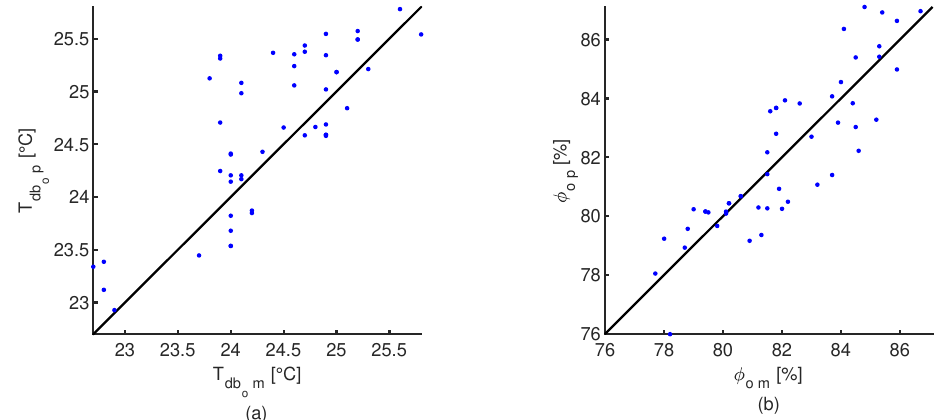
Figure 6. Relationship between the thermal conditions at pad outlet predicted with the CFD model ( p ) and experimental measurements ( m ). ( a ) —Outlet air dry-bulb temperature ( T db relative humidity ( φ o ). Solid black line corresponds to the equality line.